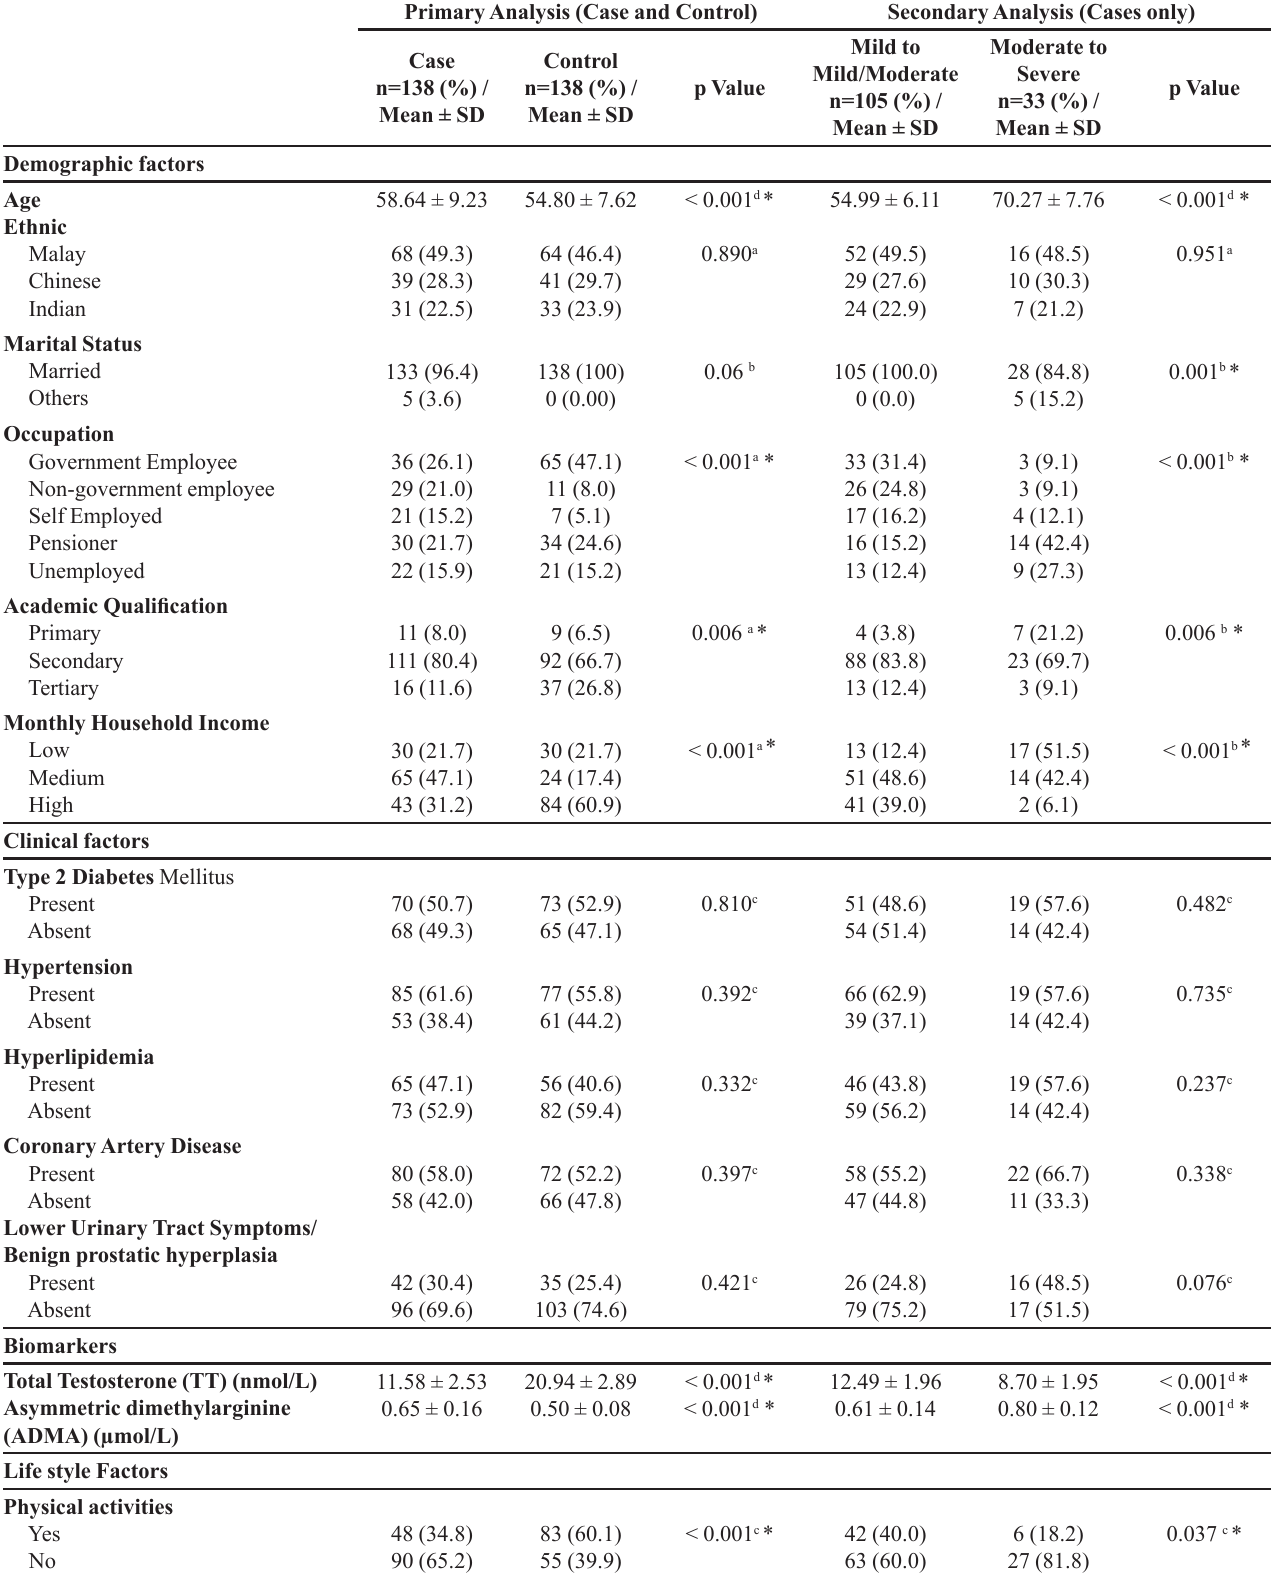
TABLE I - Association of Demographic, Clinical, Biomarkers and Lifestyle factors with Erectile Dysfunction and Severity of ED Primary Analysis (Case and Control) Secondary Analysis (Cases